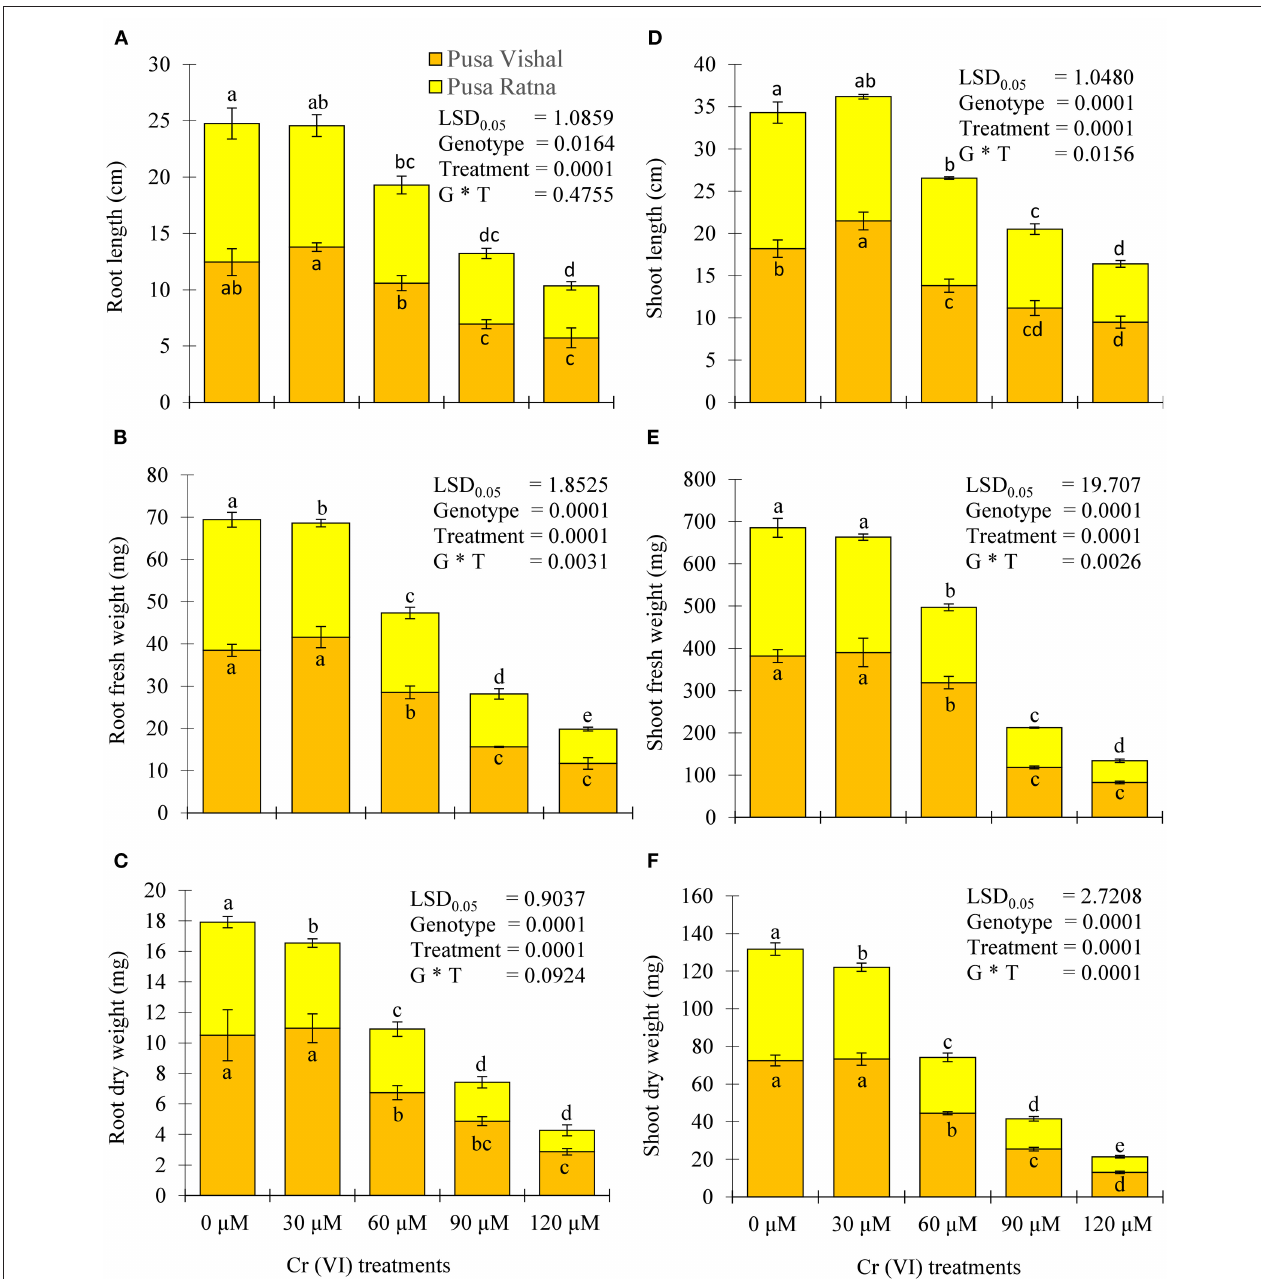
FIGURE 3 | Effect of different chromium (Cr [VI]) concentrations on (A) root length, (B) root fresh wieght (C) root dry weight, (D) shoot length, (E) shoot fresh wieght, and (F) shoot dry weight of two Mungbean cultivars, Pusa Vishal (PV) and Pusa Ratna (PR), grown in hydroponic conditions. Mean values of three replicates are shown; error bar ( ± standard error [SE]). Mean values with the same letter don’t have significant difference at p ≤ 0.05, according to the Least Significant Difference test (LSD 0.05